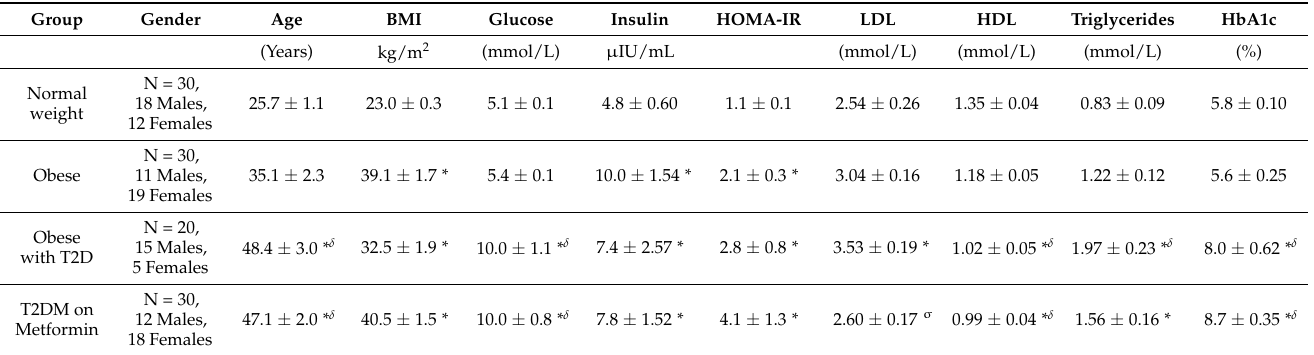
Table 2. Demographic data of the study